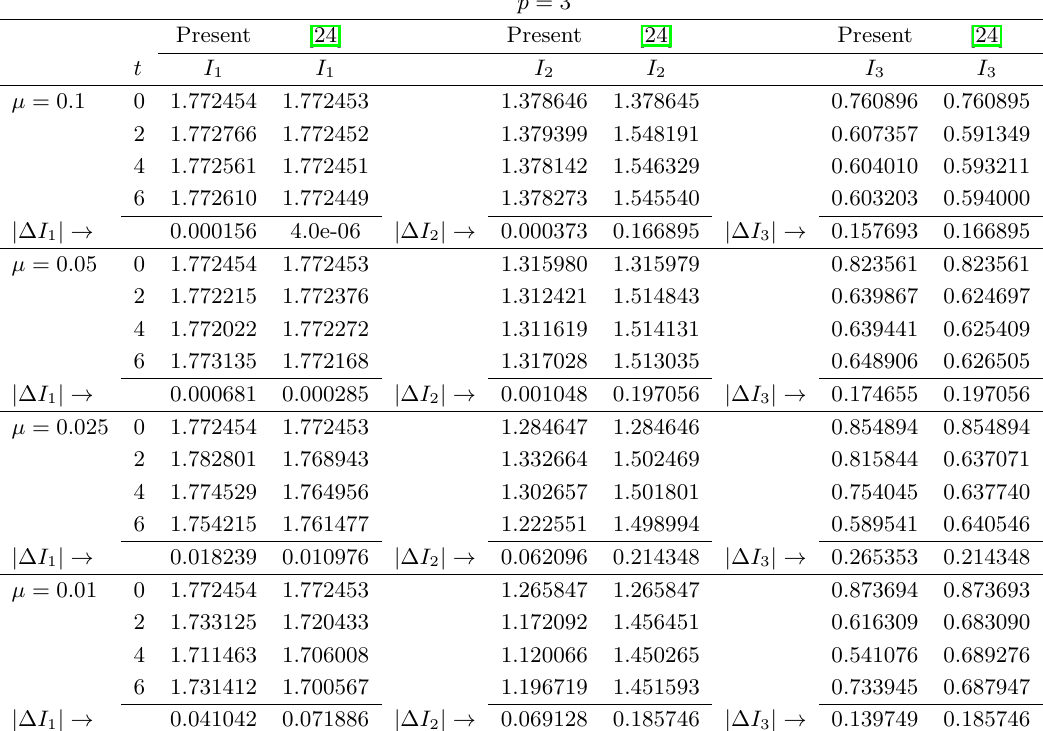
Figure 6. Interaction of three solitary waves for p = 3, N = 400, µ = 1 ,c 1 = 0 . 6, c 2 = 0 . 3, c 3 = 0 . 15, x 1 = 15, x 2 = 35 and x 3 = 60 at t = 0 , 2 , 4 , 6 , 8 , 10. Table 14. Invariants and their comparison for p = 3 , N = 400, ∆ t = 0 . 005 and different values of µ